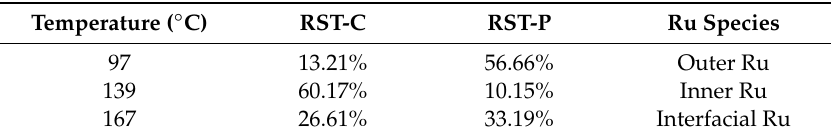
Figure 5. H 2 -TPR profiles of the catalysts. Table 3. Proportion of different peaks in H 2 -TPR.